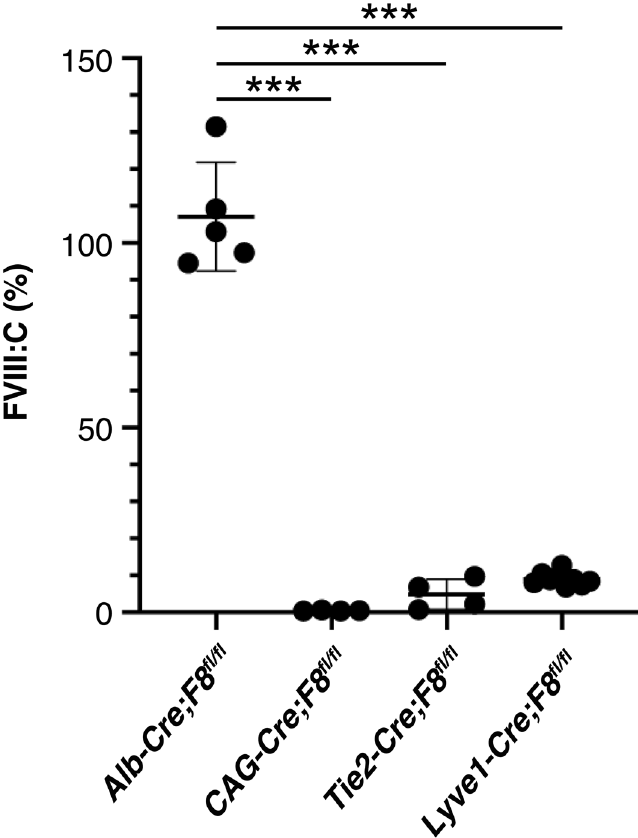
Figure 5. Decrease in plasma FVIII activity by the conditional deletion of F8 . Plasma levels of FVIII activity (FVIII:C) were measured by one-stage clotting assay in the conditional knockout F8 male mice obtained by crossing F8 fl/fl mice with Alb-Cre , CAG-Cre , Tie2-Cre , or Lyve1-Cre mice. Dots represent plasma FVIII:C levels in each mouse. Bars are means ± SEM (n = 4–8). *** P < 0.0001 (2-tailed Student’s t